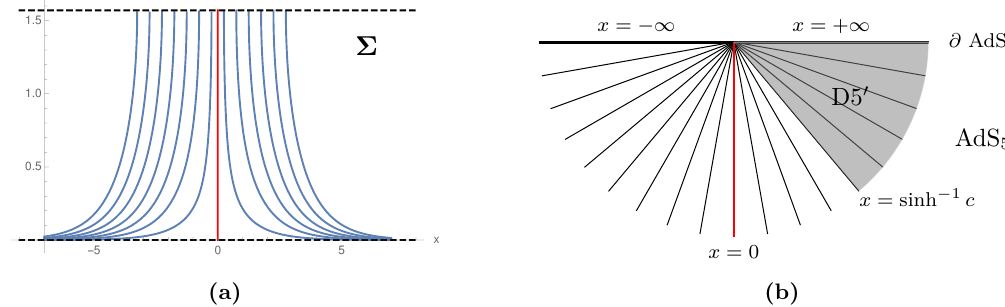
Figure 4. Left: D5 0 embeddings in AdS 5 × S 5 on the strip. Half-BPS Wilson loop D5 0 -branes are embedded along the red curve x = 0 , corresponding to c = 0 in (4.33). The blue curves are Janus on the brane embeddings. Right: schematic illustration of the embeddings in AdS 5 . Lines starting at the conformal boundary are AdS 4 slices, of which the D5 0 wrap an AdS 2 . The angular coordinate is x , with x = ±∞ corresponding to the conformal boundary and x = 0 to the vertical slice. The shaded region is an example of a Janus on the brane D5 0